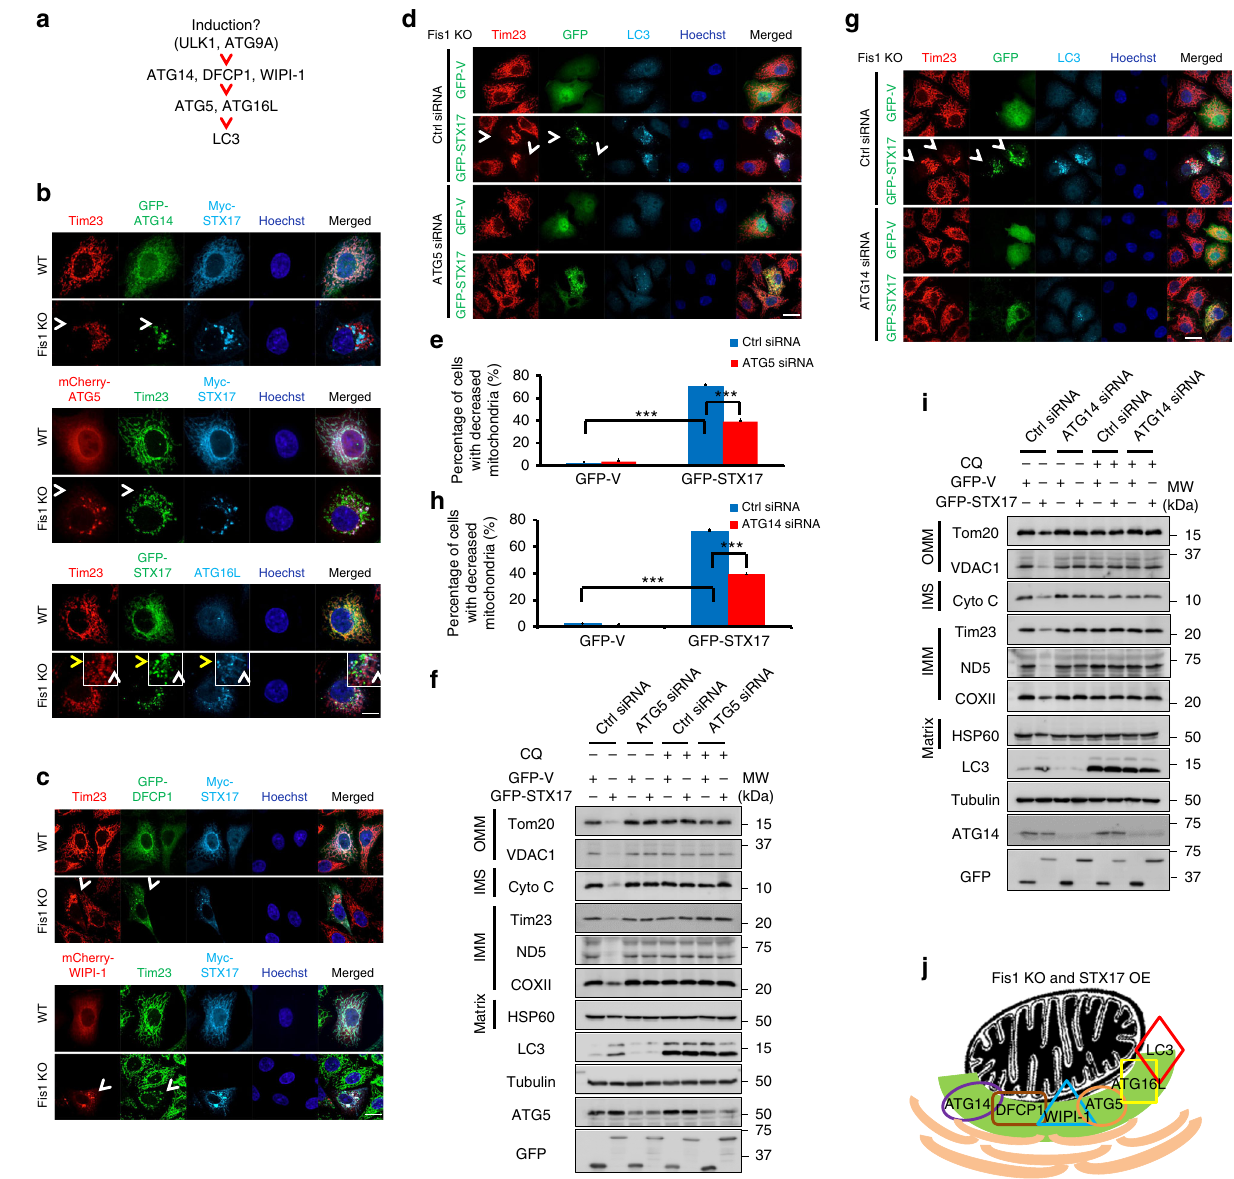
Fig. 6 Syntaxin 17 (STX17) initiates mitophagy in the hierarchical autophagic pathway. a The schematic model illustrating the genetic hierarchy and temporal relationship of autophagy proteins. b , c Wild-type ( WT ) or mitochondrial fi ssion 1 protein knockout ( Fis1 KO ) HeLa cells were transfected with the indicated plasmids for 24 h. Cells were fi xed and imaged by fl uorescence microscopy. Hoechst, blue. Scale bar, 10 µ m. Arrowheads indicate mitophagic cells. d , g Fis1 KO cells were transfected with respective small interfering RNA (siRNA) to silence the indicated genes for 24 h. Then, green fl uorescent protein (GFP)-tagged vector or STX17 (green) was transfected into cells for further 24 h. Mitochondrial Tim23 (red) and LC3 (cyan) signals are shown by confocal microscopy. Hoechst, blue. Scale bar, 10 µ m. Arrowheads indicate mitophagic cells. e , h Quanti fi cation of mitophagy percentage of d or g . Error bar represents SD. *** P < 0.001 (two-tailed unpaired Student ’ s t test from three independent experiments, n = 150). f, i Fis1 KO HeLa cells were transfected with the indicated siRNA for 24 h and then treated with respective siRNA again plus GFP-tagged vector or STX17 for further 6 h. Hereafter, cells were cultured in medium with or without chloroquine (CQ) for another 66 h. Cell lysates were immunoblotted for outer mitochondrial membrane (OMM), intermembrane space (IMS), inner membrane mitochondrial (IMM), and matrix proteins. j A schematic summary of the recruitment of canonical autophagy proteins for STX17 overexpression-induced mitophagy of Fis1 KO